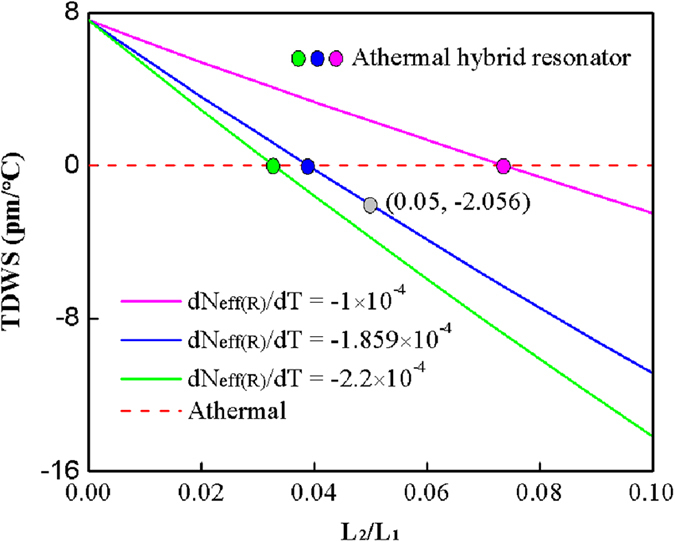
Theoretically calculated TDWSs of hybrid resonators with respect to dNeff(R)/dT and L2/L1.